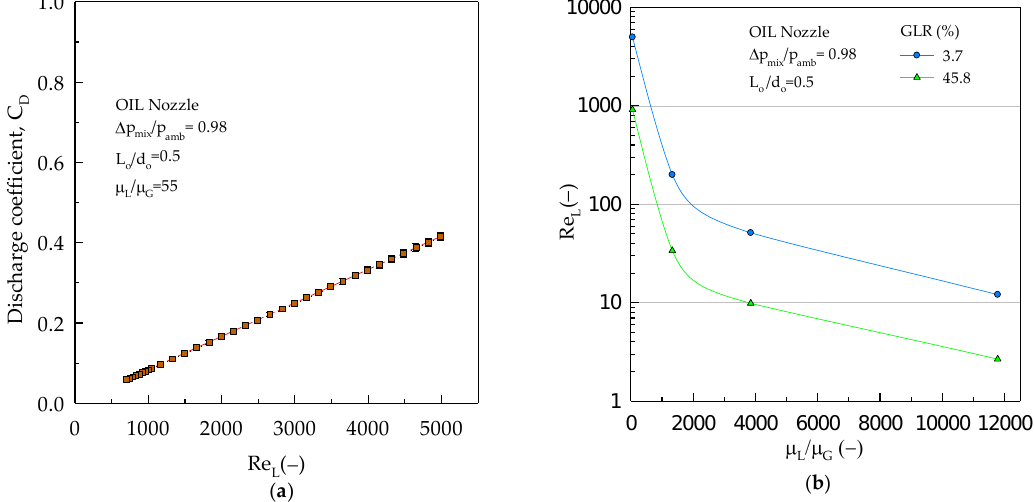
Figure 8. ( a ) The relation between Re L and C D ; ( b ) the relation between µ L /µ G and Re L at different GLRs.